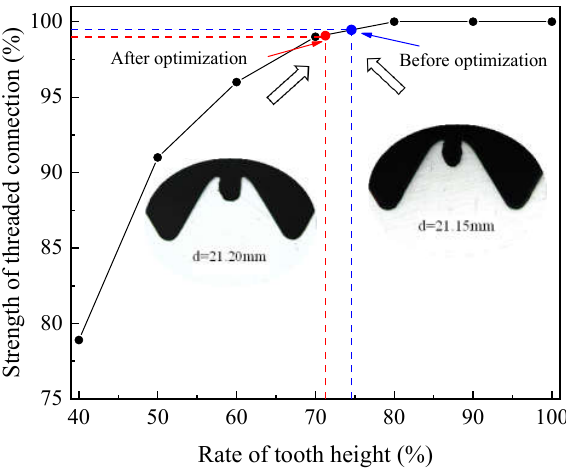
Figure 27. Strength of threaded connection before and after optimization.